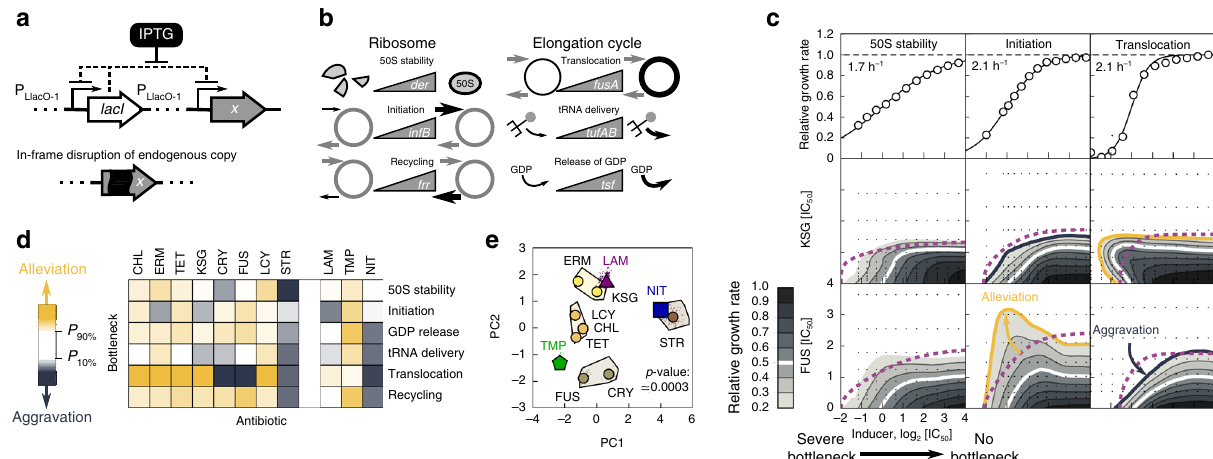
Fig. 3 Arti fi cial translation bottlenecks strongly affect antibiotic ef fi cacy. a Schematic of synthetic regulation introduced to control the expression of a translation factor x , which creates an arti fi cial bottleneck in translation at a well-de fi ned stage; lacI codes for the Lac repressor, which represses the P LlacO-1 - promoter (Methods 27 ,). b Constructs were made for six translation factors mediating 50S stability ( der ), initiation ( infB ), recycling ( frr ), translocation ( fusA ), tRNA delivery ( tufAB ) and GDP release ( tsf ), respectively. Higher expression alleviates the arti fi cial bottleneck. Thicker lines or arrows indicate higher rates. c Translation factor induction curves (upper row) and response surfaces over the inducer-antibiotic grid for different antibiotics (KSG and FUS, middle and bottom row, respectively) in combination with different bottlenecks (50S stability, initiation, and translocation). Full induction of the translation factor rescues wild type growth; increasing bottleneck severity leads to a smooth decrease in growth rate to zero. Induction curves were measured in n = 8 technical replicates, and the median value of non-zero growth rates was calculated. Comparison of the response surfaces with independent expectation (dashed purple line) identify alleviation (orange line) or aggravation (dark blue line). d Columns show bottleneck dependency vectors in color-code; dependency vectors quantify the response of a given antibiotic to the translation bottlenecks (Supplementary Information). e Clustering of the bottleneck dependency vectors upon dimensionality-reduction by principal component analysis (PCA; Supplementary Information). Circles show dependency vectors projected onto the fi rst two principal components (PC1, and PC2); colors indicate cluster identity. The extended cluster areas shown are convex hulls of bootstrapped projections (denoted by dots). Projections of the three additional antibiotics LAM, NIT, and TMP are denoted by a purple triangle, blue square, and green pentagon, respectively. We estimated the p -value by clustering n = 10 4 reshuf fl ed datasets with added noise and counting the fraction of instances that matched the shown clustering result. See Supplementary Equations (19 – 20) and Supplementary Fig. 3e; we did not use a